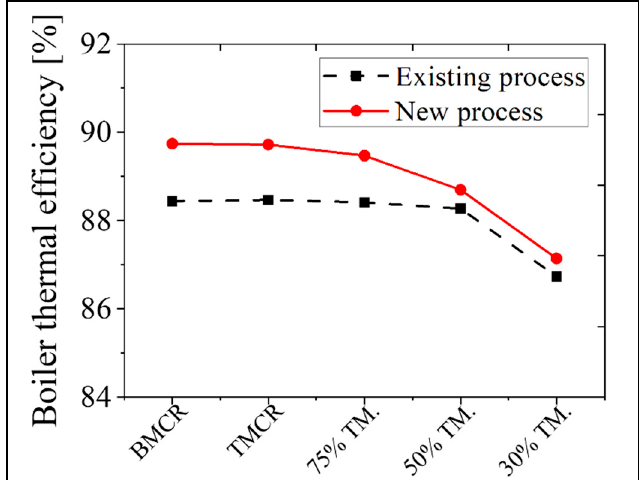
Figure 14. A comparison of the results for the thermal efficiency of the boiler in the existing and new processes based on the load conditions.